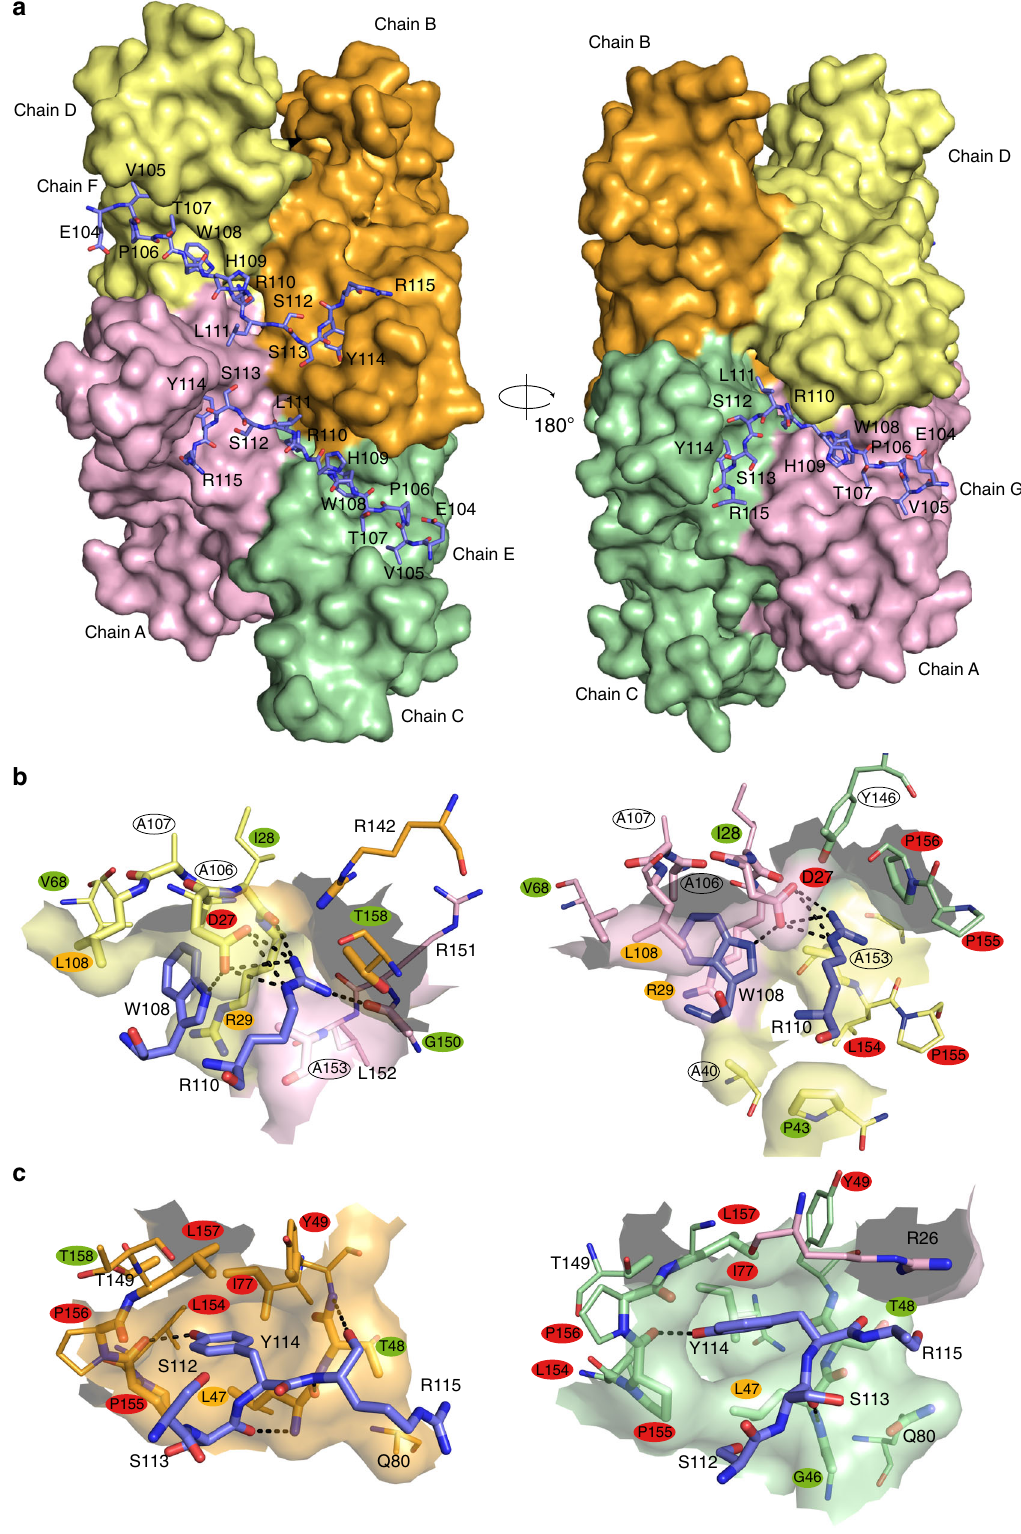
Fig. 2 ChAD binding on Mtb -SecB TA . a Molecular surface of the tetramer. The three bound peptides are shown as a stick representation with carbon, nitrogen, and oxygen atoms in slate blue, blue, and red, respectively. The protein and peptide chains as well as ChAD residues have been labeled. Left and right views are separated by a 180° rotation around a vertical axis. b Close-up view centered on ChAD residues W108 and R110. c Close-up view centered on ChAD residue Y114. In b and c , Mtb -SecB TA atoms found within 5 Å of the peptides are shown as enlarged sticks and depict the ChAD-binding site shown as a semitransparent surface. Polar interactions are represented by black dotted lines. Views on the left (resp. right) are for subunit F (resp. G). Color coding of interacting residues is the same as in Fig.